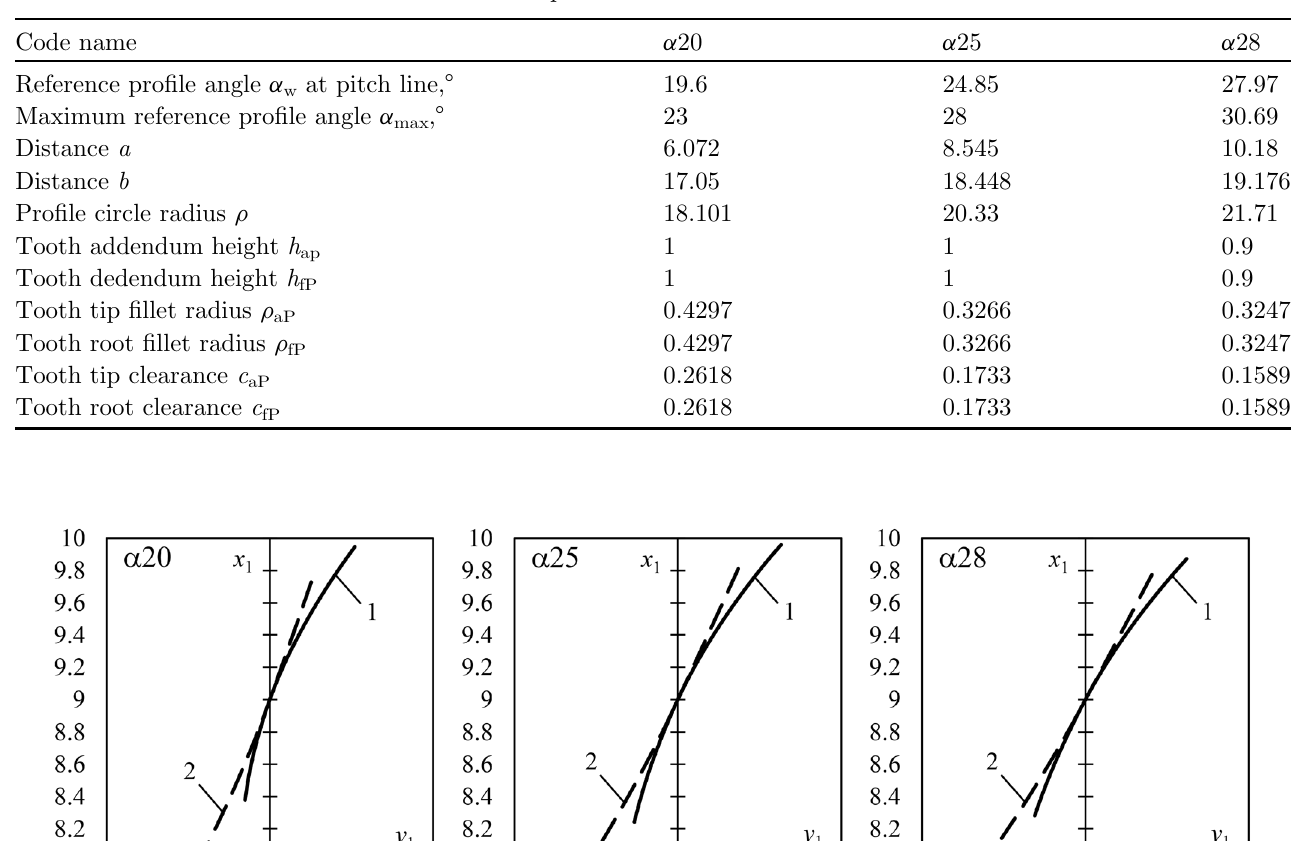
Table 1. Parameters of the simulated reference pro fi les normalised for m = 1 mm.